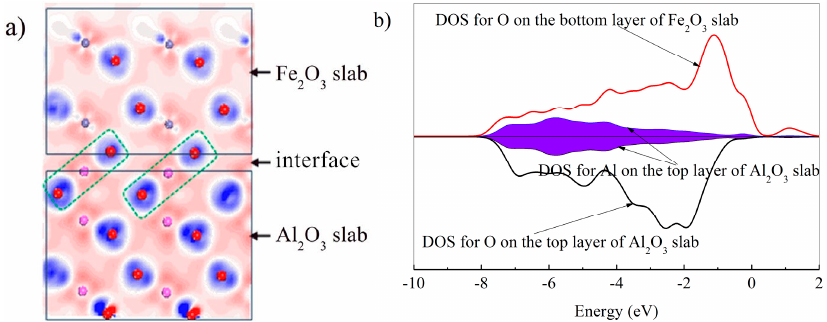
Figure 12. ( a ) The electron density difference in the isosurface (0.1) of the Fe 2 O 3 /Al 2 O 3 slab and ( b ) the total density of state (DOS) for the O atom on the bottom layer of Fe 2 O 3 , as well as that for the O and Al atom on the top layer of Al 2 O 3 . Al atom on the top layer of Al 2 O 3 .